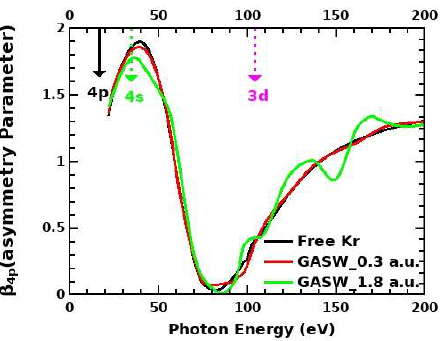
Figure 8. The average angular asymmetric parameter β 4 p of free and confined Kr. Vertical arrows indicate the threshold values of the corresponding subshells used in the RRPA.